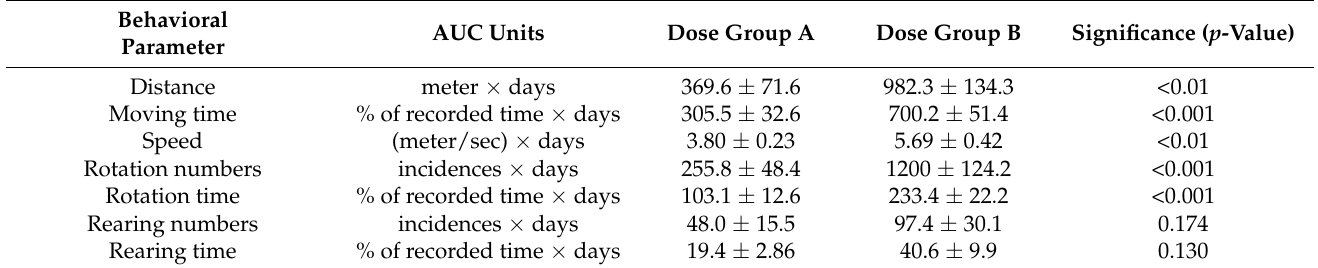
Table 2. Overall comparison of motor behaviors between different dosing groups. Total scoring of recorded motor behaviors (presented as area under curve; AUC) were calculated from the behavioral curves in Figures 3 and 4. Statistically significant differences between AUCs of each behavior were assessed using an unpaired t